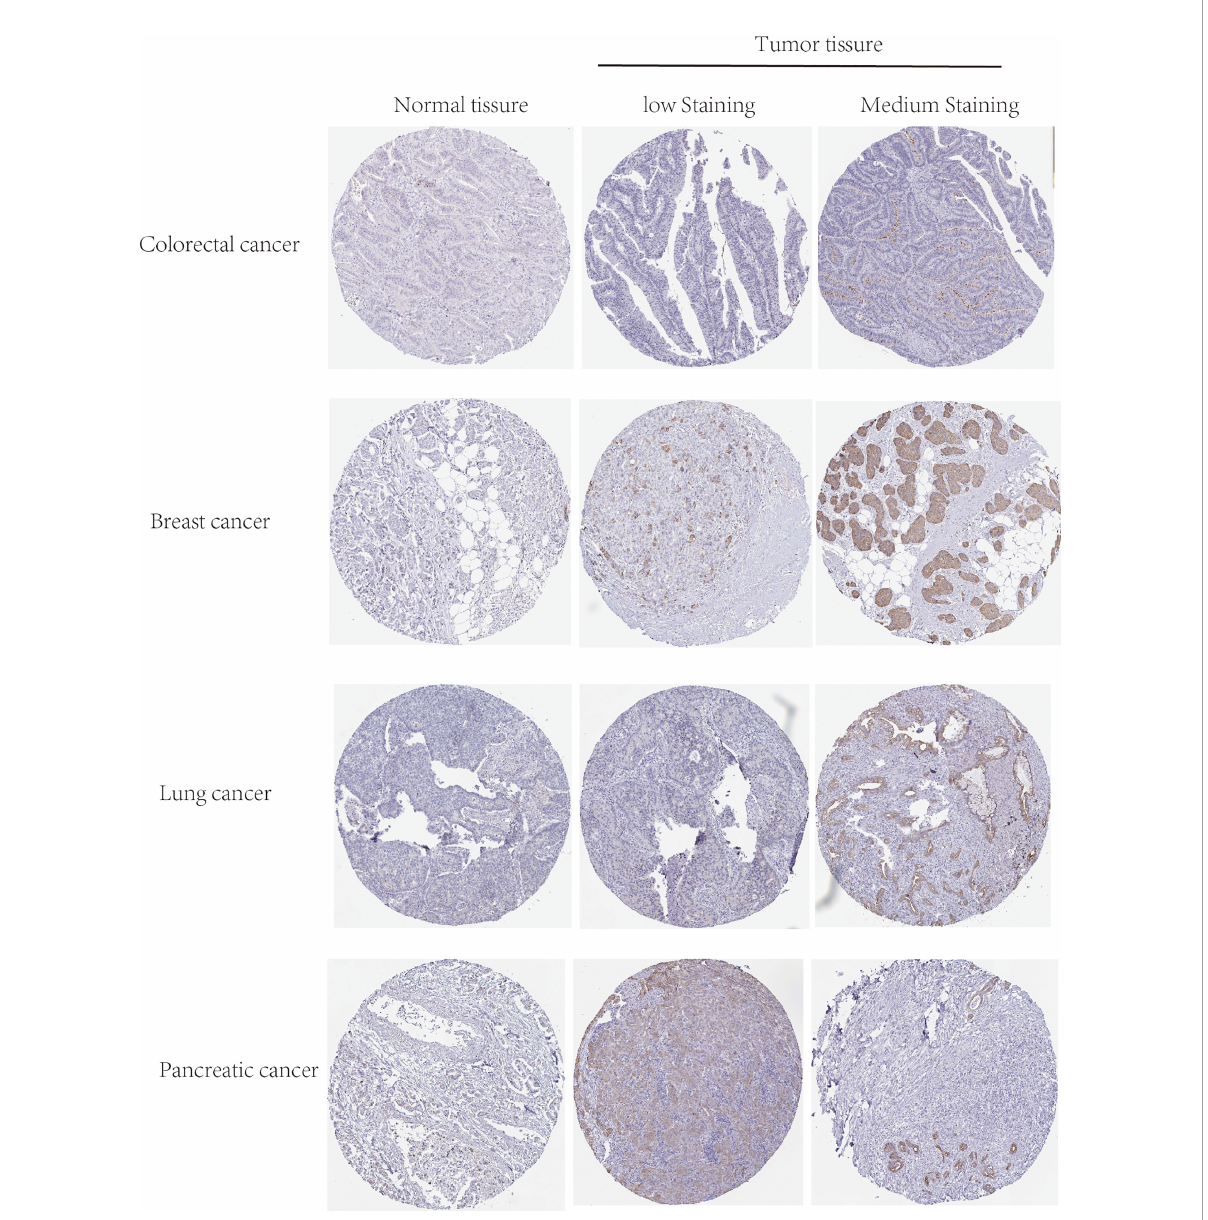
FIGURE 3 The protein level of TGR5 between normal, low, and medium staining in colorectal, breast, lung, and pancreatic cancers by immunohistochemistry